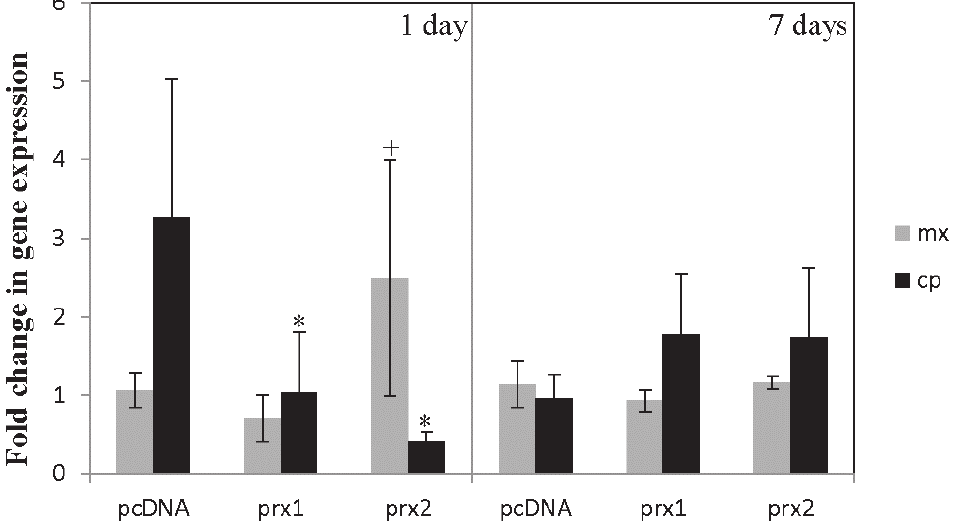
Figure 2. Expression levels of the antiviral mx and the nodavirus capsid protein ( cp ) genes in the brain of European sea bass specimens injected with expression plasmids (pcDNA alone or containing the gilthead seabream prx1 or prx2 genes) and infected with NNV. Bars represent the mean ± SEM ( n = 4) referenced to the values found in control